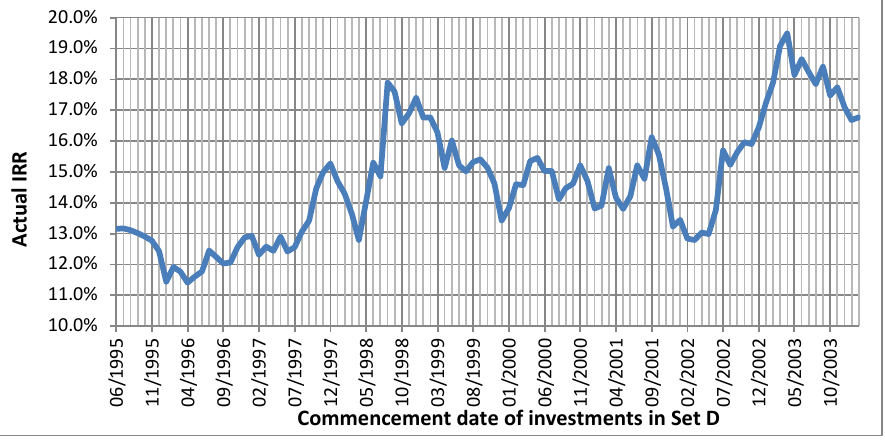
FIGURE 6: IRRs of Set D simulated living annuities invested in the Topi Source: Authors’ deductions FIGURE 6 indicates a range of IRRs between 11.4% and 19.5% for Set D investments in the Topi. The minimum IRR is in excess of the target return of 11.07%.